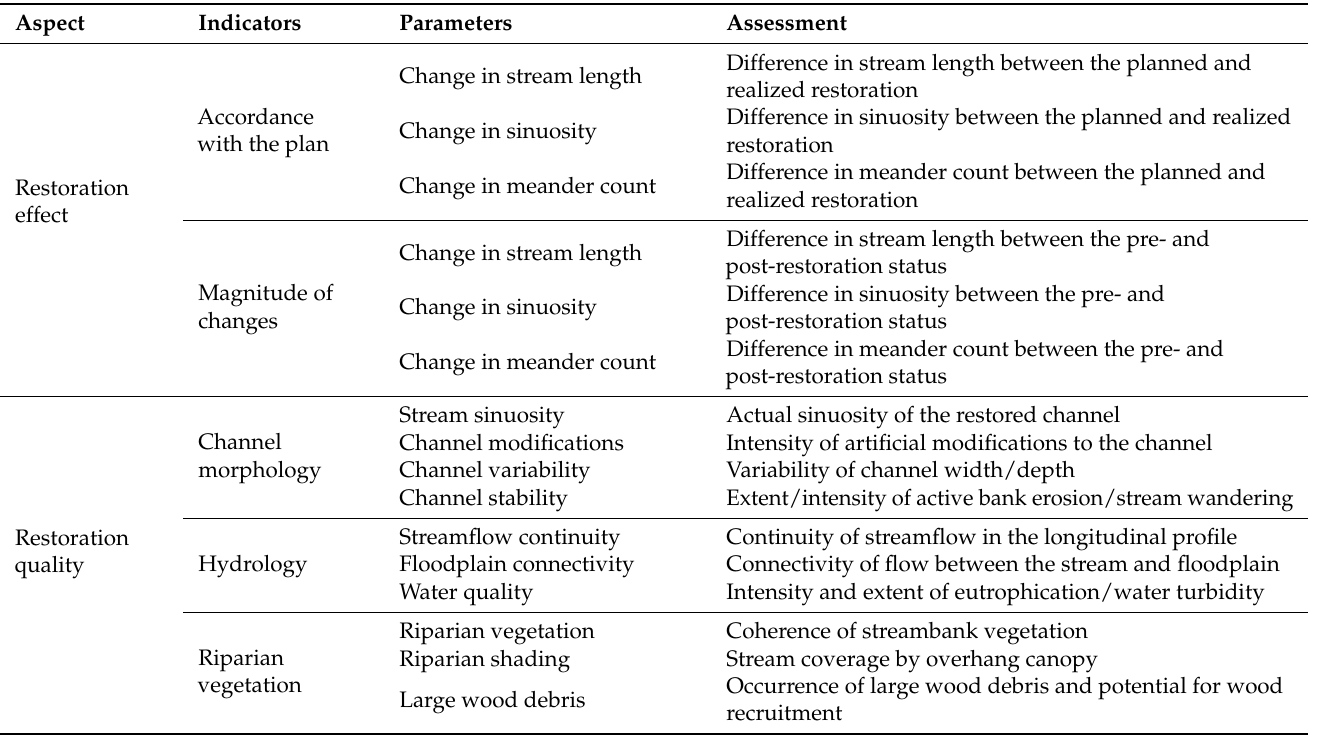
Table 3. Indicators of the restoration effect and quality, derived from UAV